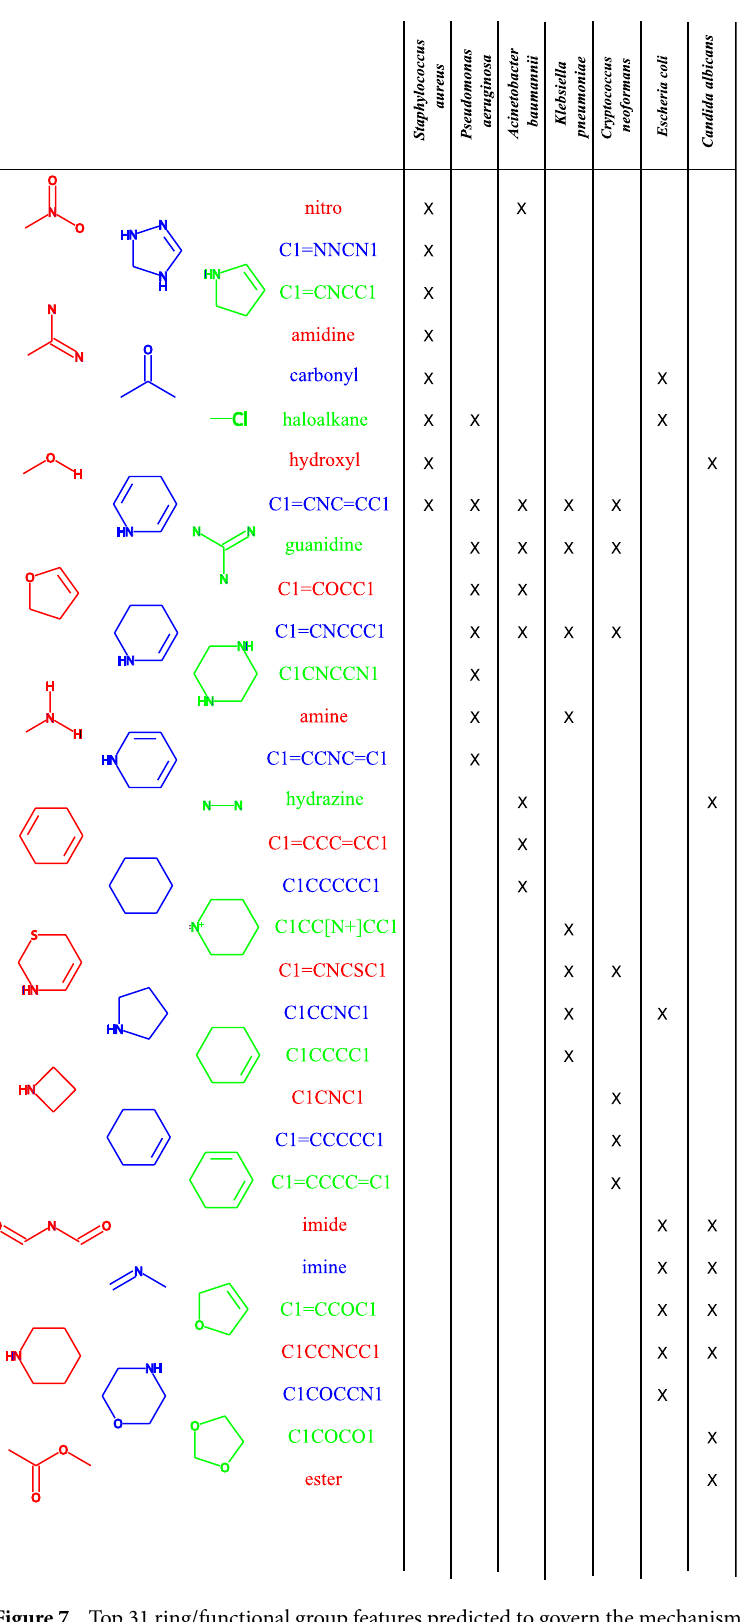
Figure 7. Top 31 ring/functional group features predicted to govern the mechanism of action of molecules along with pathogens they